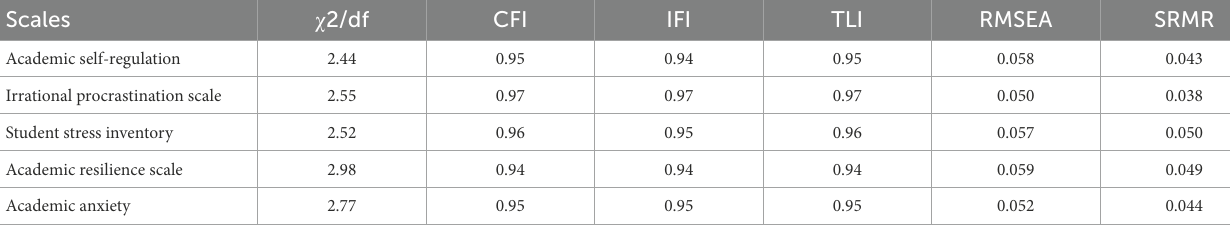
TABLE 3 Confirmatory factor analysis of the